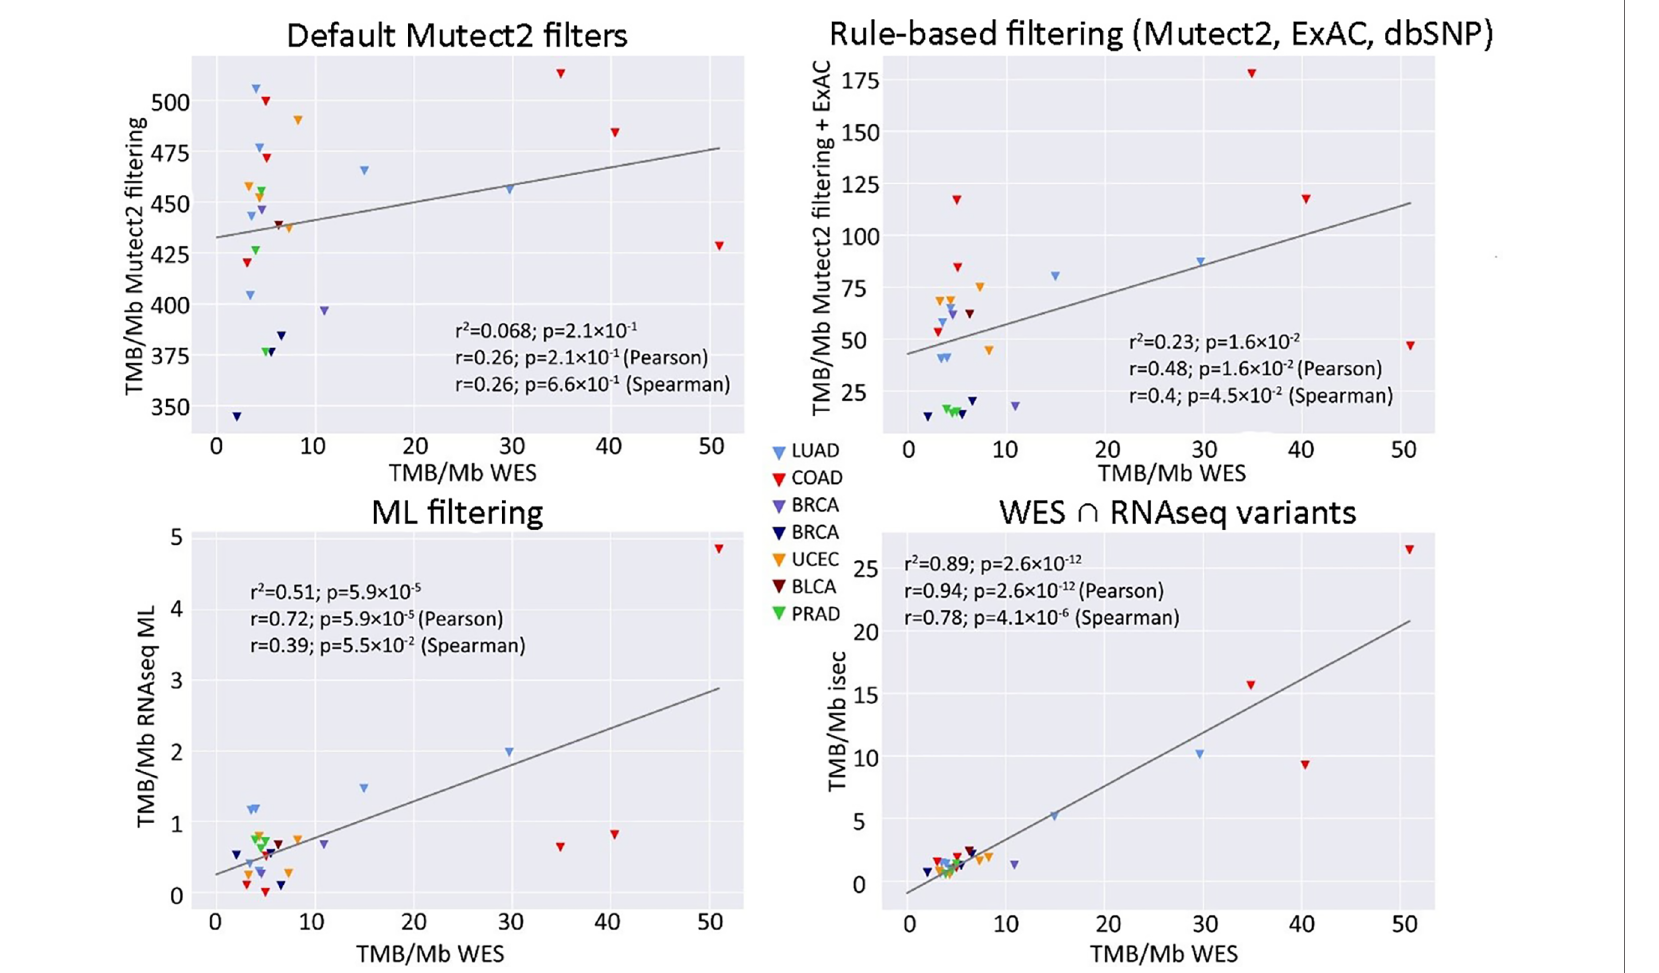
FIGURE 5 | Correlations between RNAseq- and WES-derived TMB estimates (TCGA FFPE dataset, n = 26), without matched normal WES references. Samples are colored according to cancer type. Cancer type abbreviations used: LUAD, lung adenocarcinoma; COAD, colon adenocarcinoma; BRCA, breast invasive carcinoma; UCEC, uterine corpus endometrial carcinoma; BLCA, urothelial bladder carcinoma; PRAD, prostate